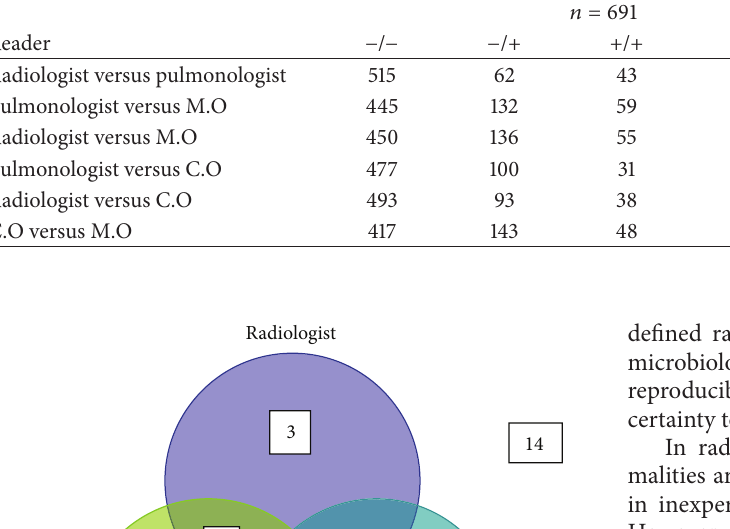
Table 4: Agreement on any abnormality on chest radiograph [ (+) abnormal/( − ) normal ] .